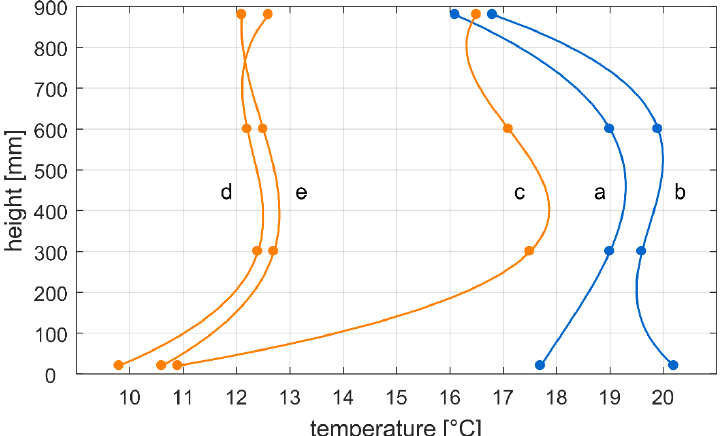
Figure A4. Illustrative single temperature measurement for the roof window — vertical temperature profile along the window. a : a distance of 15 mm from the glazing. b: a distance of 80 mm from the glazing. c, d, and e: glass temperature in the center of the window, at the left edge of the window, and at the right edge of the window, respectively. The indoor air temperature was 21.5 °C, the surface temperature of the heating body was 27 °C, and the exterior air temperature was 0 °C.